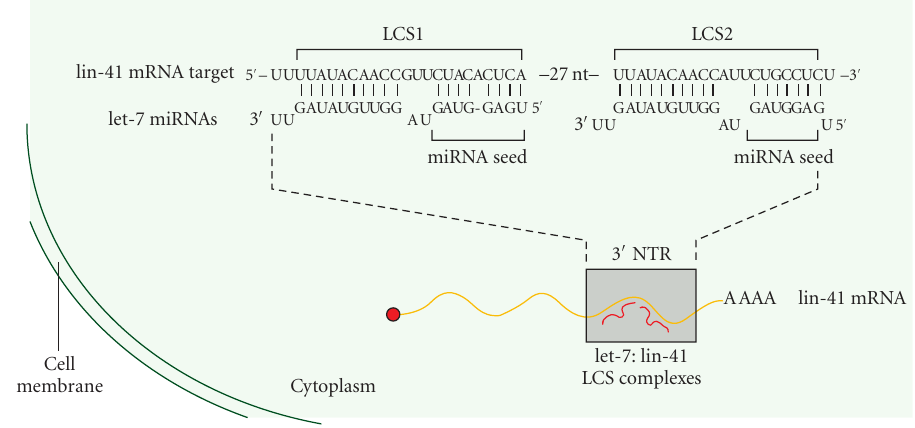
Figure 3: Recognition of the lin-41 mRNA by let-7 in C elegans . The lin-41 3 (cid:3) NTR contains two let-7 complementary sites (LCS) separated by a 27nt sequence that seems to be important in target recognition [143]. The miRNA seed consists in a perfect pairing of nucleotides 2 to 8 of the